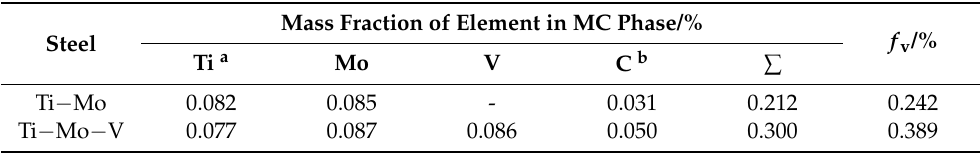
Table 3. Quantitative analysis of MC precipitates of Ti − Mo and Ti − Mo − V